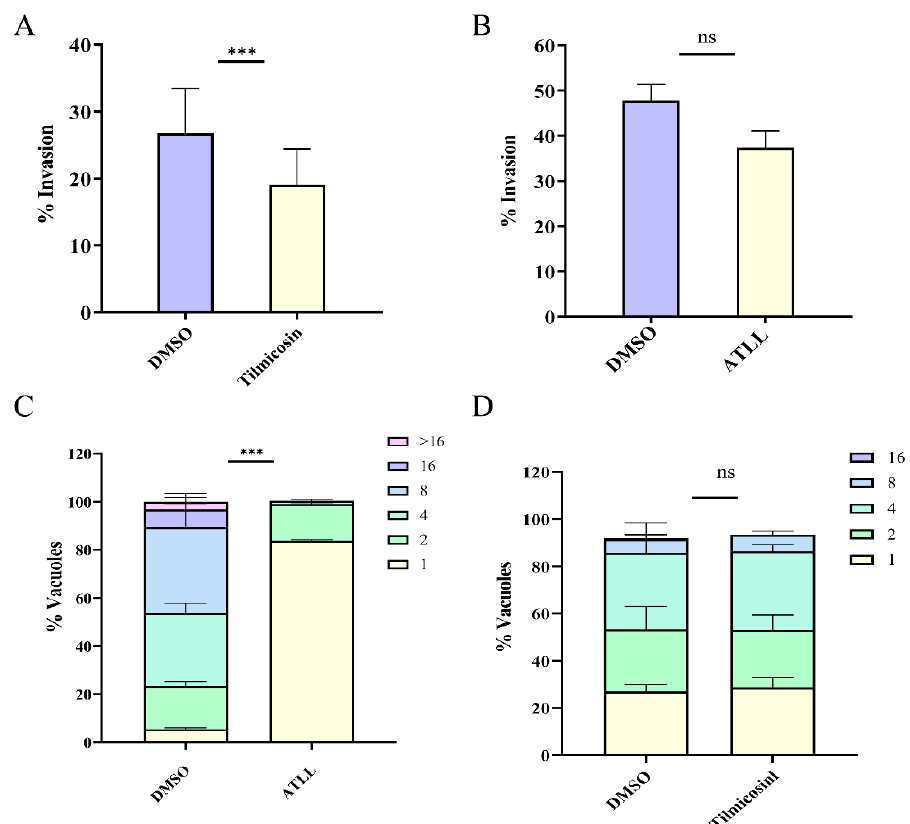
Figure 4. Differential effects of tilmicosin and ATLL on tachyzoite invasion and proliferation. 1 × 10 5 parasites were inoculated onto HFF cells in 12-well plates and cultured for 24 h with 26.94 μ M tilmicosin ( A ) or 16 μ M ATLL ( B ). DMSO was used as a control. IFA was performed with anti- TgGAP45 antibody and Hoechst. Invasion rates of parasites treated with different fractions were based on the number of parasite-infected cells divided by the total number of cells in one horizon. Asterisks indicate statistically significant results ( p < 0.05 as determined by t- test). Data are means ± SD (error bars) of three independent experiments. Intracellular replications of parasites were determined by 26.94 μ M tilmicosin ( C ) or 16 μ M ATLL ( D ) treatment. The experiments were compiled from three separate assays, and in each assay, 100 total PVs of each strain were counted. Data were determined by two-way ANOVA analysis. Asterisks indicate statistically significance. ns = not significant, and *** p < 0.001.